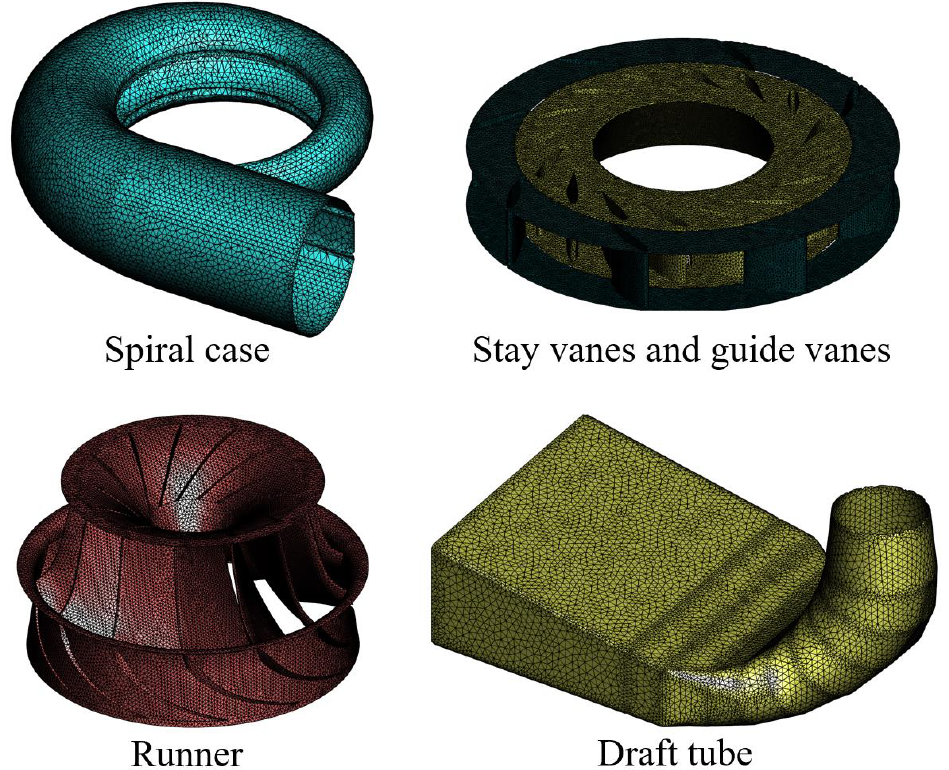
Figure 3. Structured hexahedral grids of each flow component.